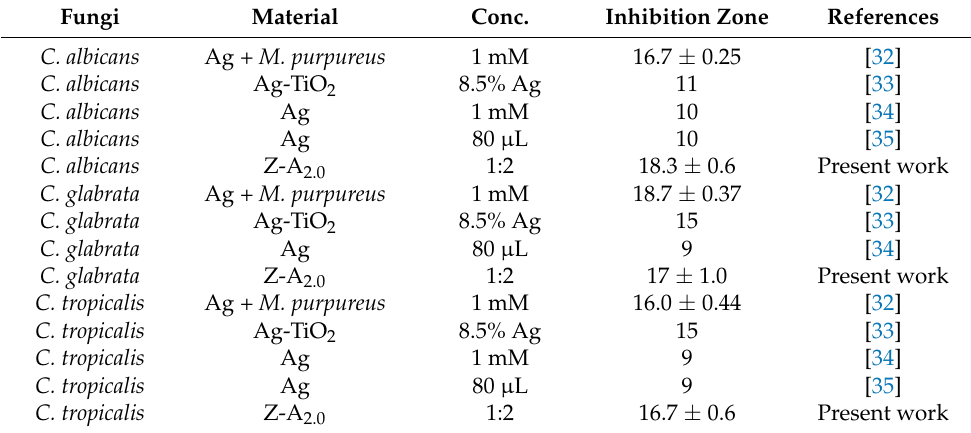
Table 2. Comparison of the zone of inhibition (mm) formed by different reported materials against some Candida spp. with the synthesized Z-A 2.0